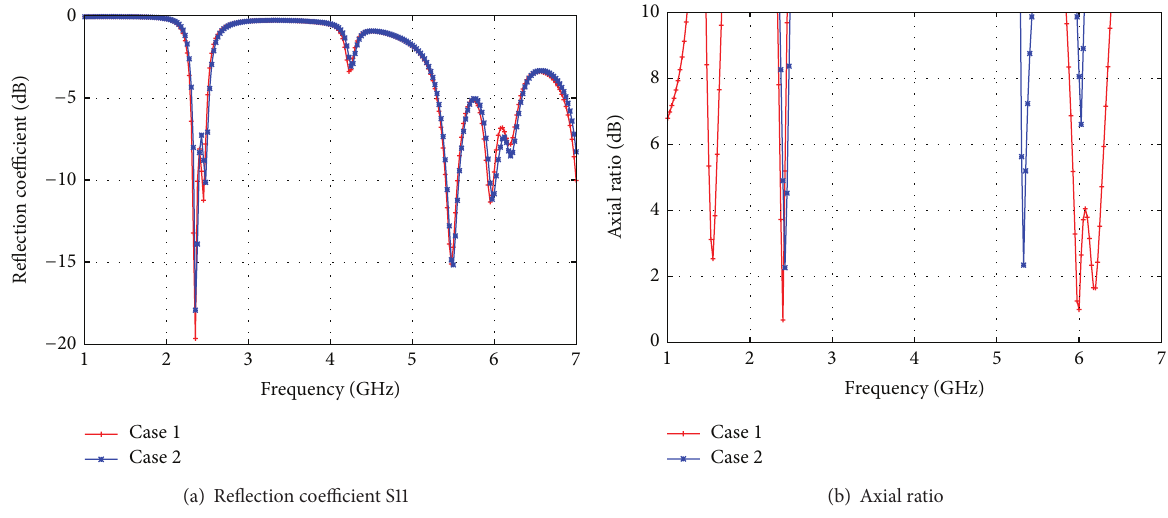
Figure 3: Coax-fed dual-band CP antenna S11 and axial ratio results.